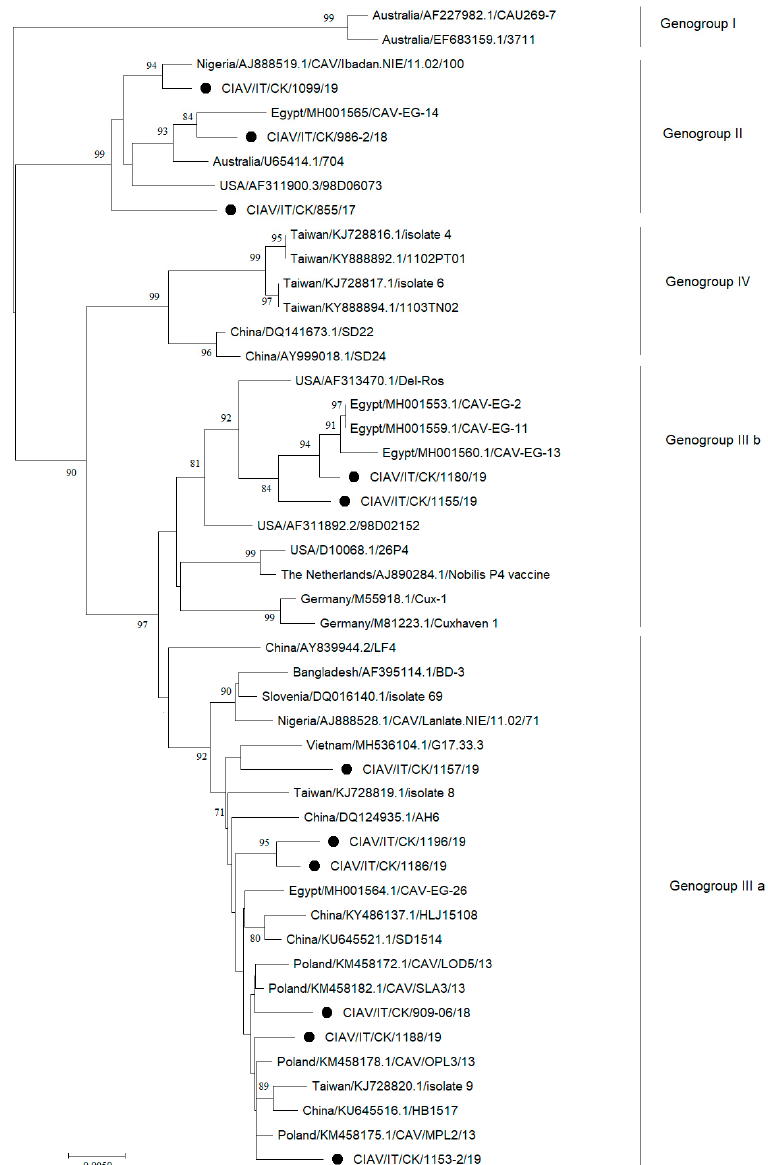
Figure 3. Phylogenetic tree based on complete VP1 nucleotide sequences of eleven Italian CIAV strains (marked with a black circle) and reference CIAV strains retrieved from GenBank. Genogroup classification is also indicated on the right of the tree. Only bootstrap values ≥ 70 are reported. The tree is drawn to scale, with branch lengths in the same units as those of the evolutionary distances used to infer the phylogenetic tree.